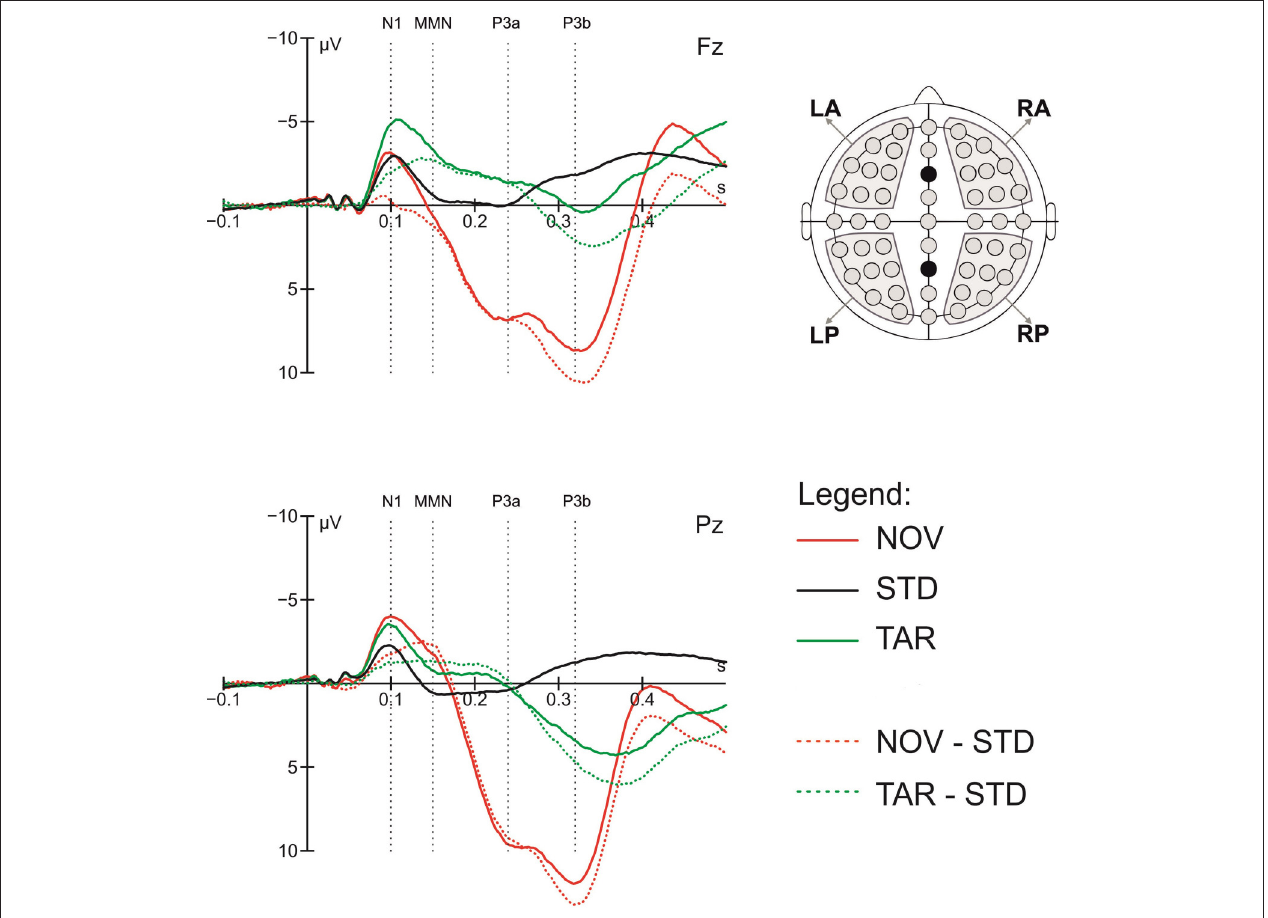
FIGURE 1 | Grand average ERP response to standards (STD), targets (TAR) and novels (NOV), novel-standard (NOV-STD), and target-standard (NOV-TAR) difference waves at the Fz and Pz electrode and component definition; the head on the right shows regions of interest (ROIs) used in the statistical analysis; dotted lines show center of the 60ms time windows for the N1, MMN, P3a, and P3b component.